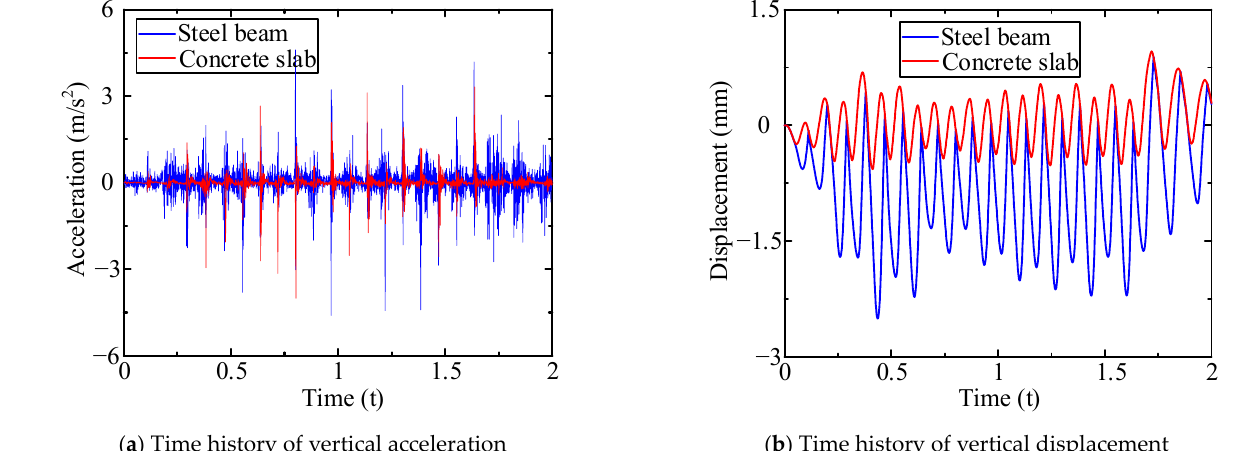
Figure 10. Time history of acceleration and displacement of the composite beam.